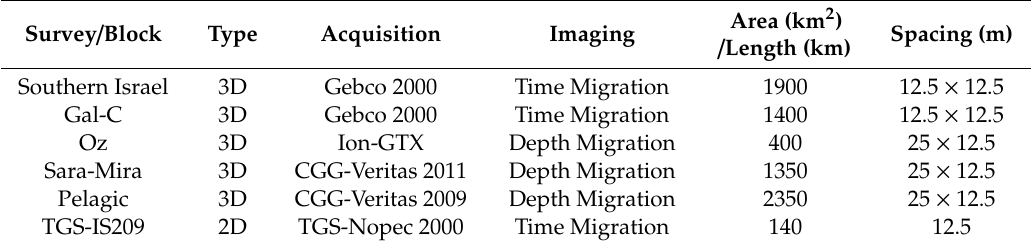
Table 1. The seismic datasets